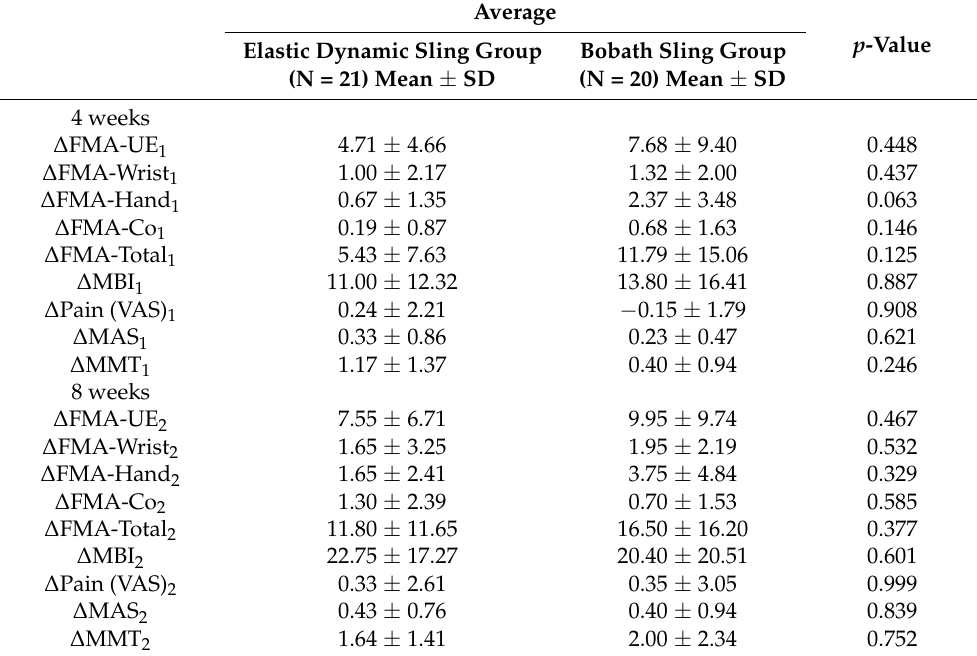
Table 6. Comparison of VAS, FMA-UE, MBI, MAS, and MMT between groups at four and eight